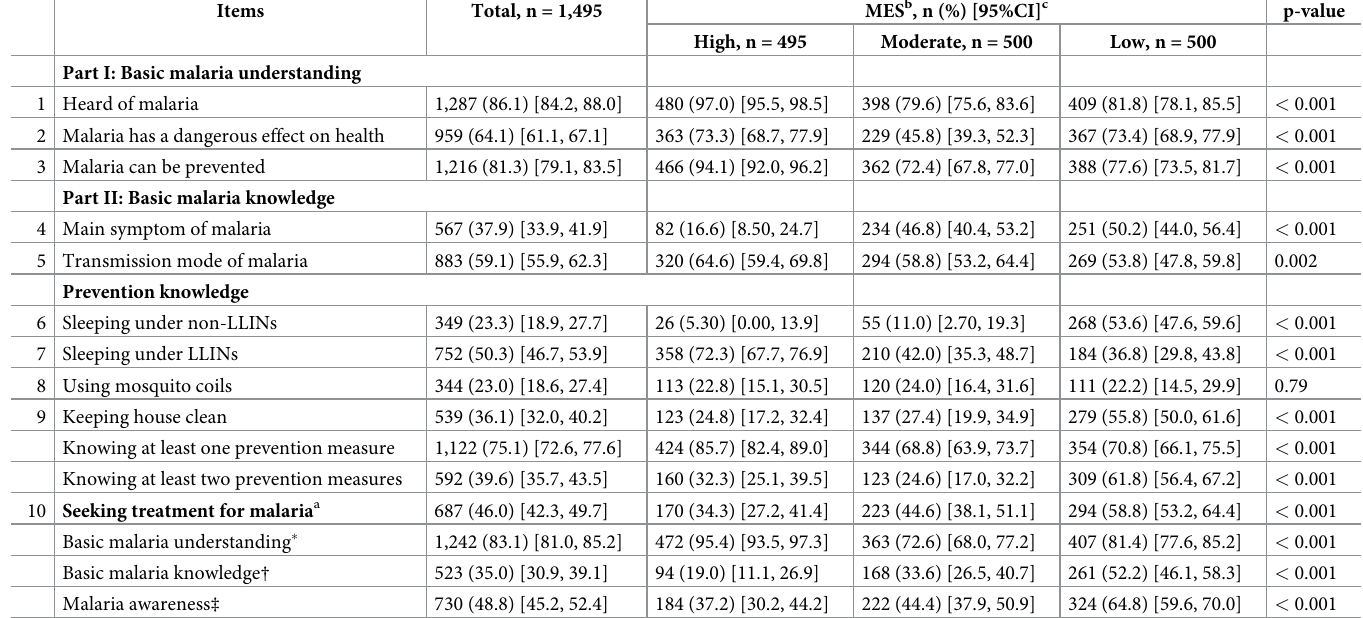
Table 2. Distribution of malaria knowledge of rural adults in three different malaria-endemic settings (MESs) in the East Nusa Tenggara Province (ENTP), Indonesia.